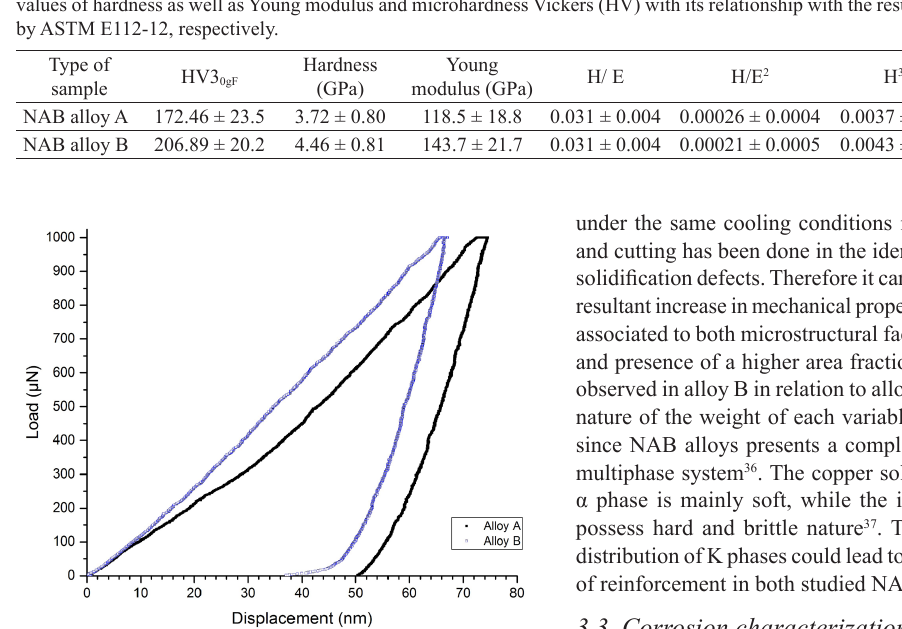
Figure 6. Nanoindentation curves for a final load of 1 mN in the NAB alloy A (blue plot) and in the NAB alloy B (black plot), respectively.